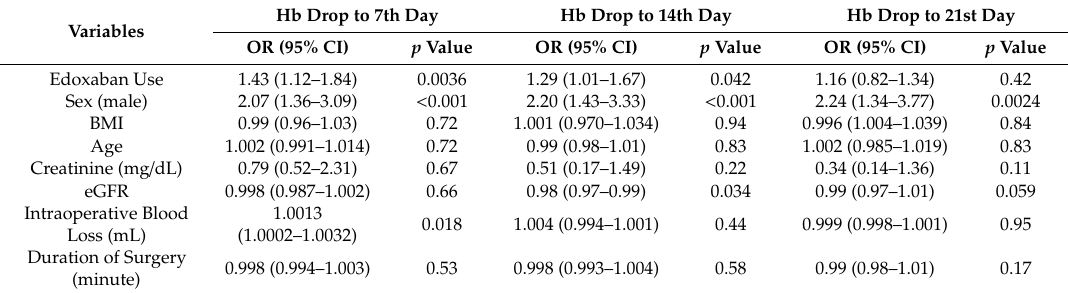
Table 3. Correlation coe ffi cients and p values for each variable obtained by multivariate regression analysis with a drop in Hb from preoperatively to each time point as the dependent